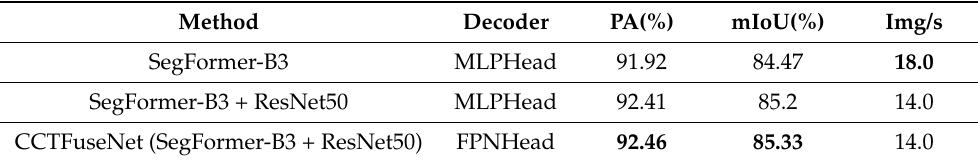
Table 4. Performance analysis of the decoders. The best results are in